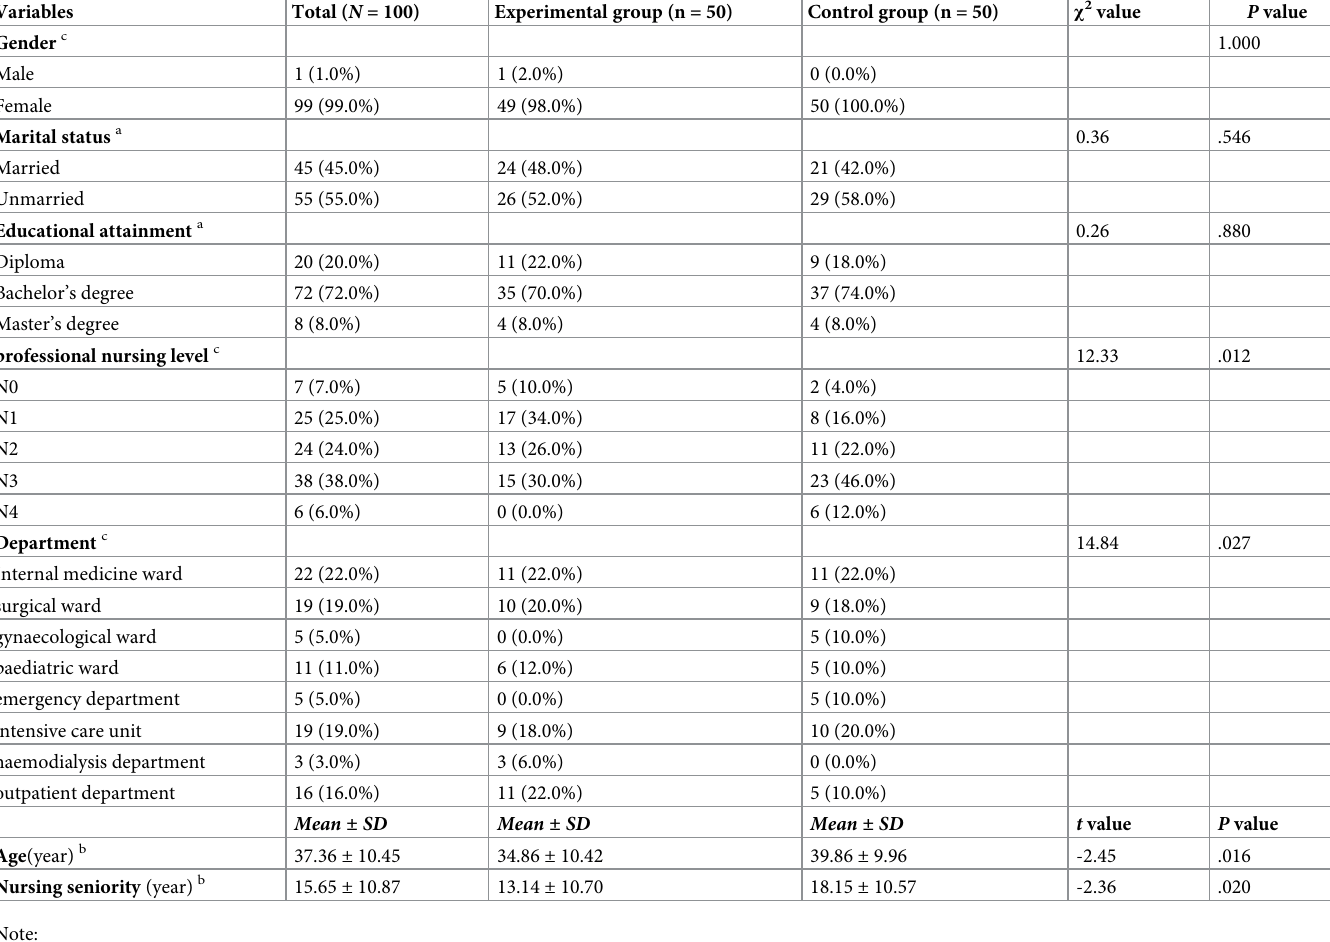
Table 1. Participant characteristics in the two